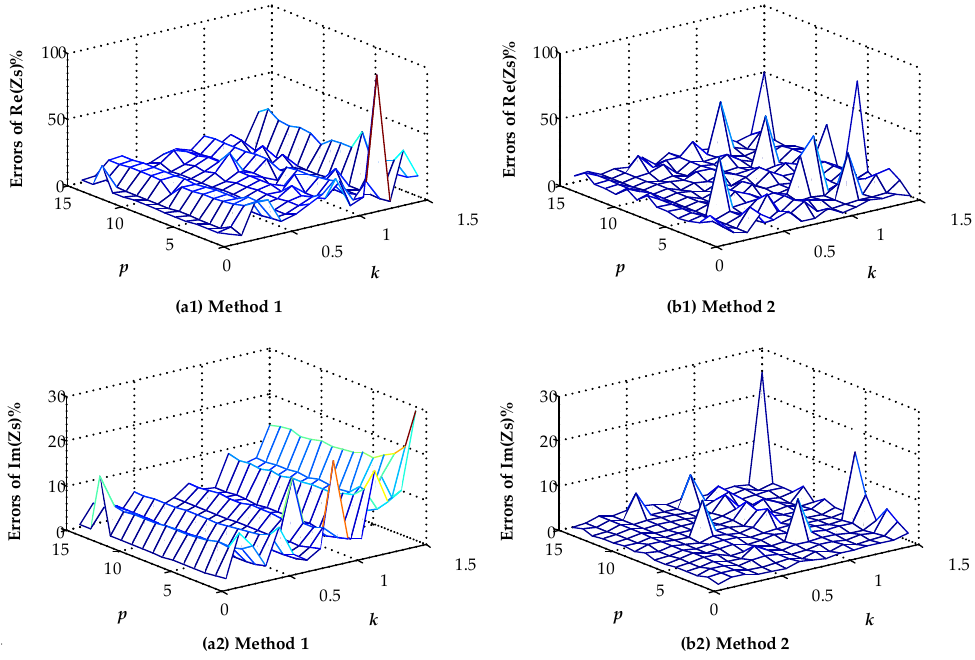
Figure 7. ( a1 ) Errors of impedance - real part for method 1; ( a2 ) Errors of impedance - imaginary part for method 1; ( b1 ) Errors of impedance - real part for method 2; ( b2 ) Errors of impedance - imaginary part for method 2.